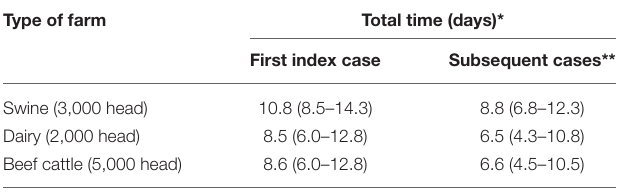
FIGURE 2 | Sensitivity analysis of the influence of the input time intervals on the total time from detection to depopulation of premises during an FMD outbreak. (A) Dairy premises. (B) Swine premises. (C) Beef cattle premises. TABLE 5 | Total time from infection to beginning depopulation.